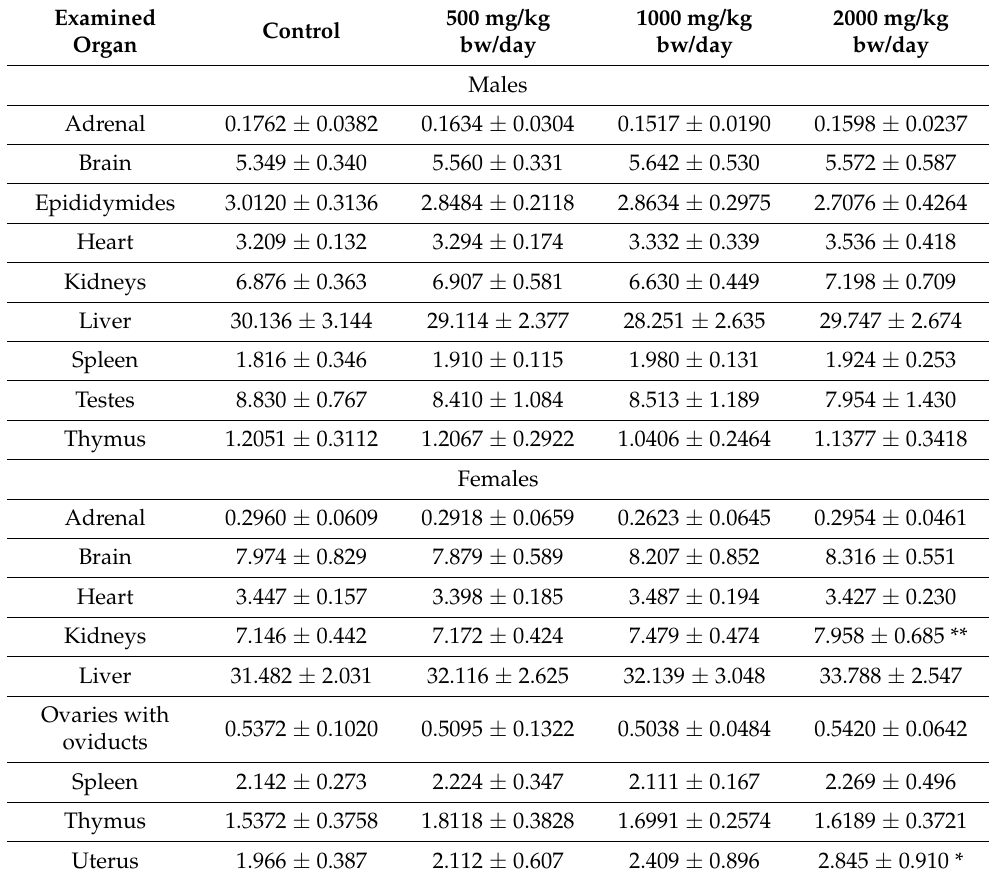
Table 7. Organ-to-bodyweight ratio.